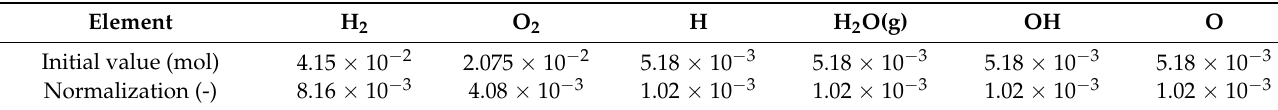
Table 1. Brown’s gas parameters in numerical